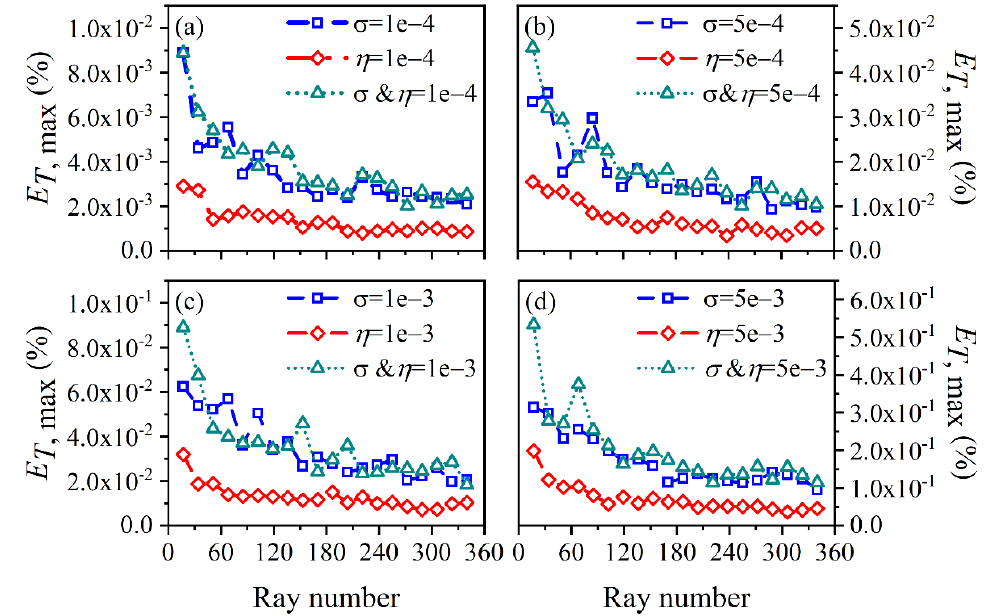
Figure 4. The maximum relative reconstruction error for temperature under different ray numbers considering the measurement error of the radiation intensity and coefficient matrix. ( a ) SNR = 80 dB;